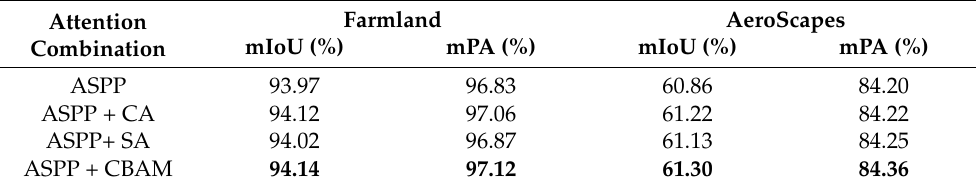
Table 2. ASPP module: different attention